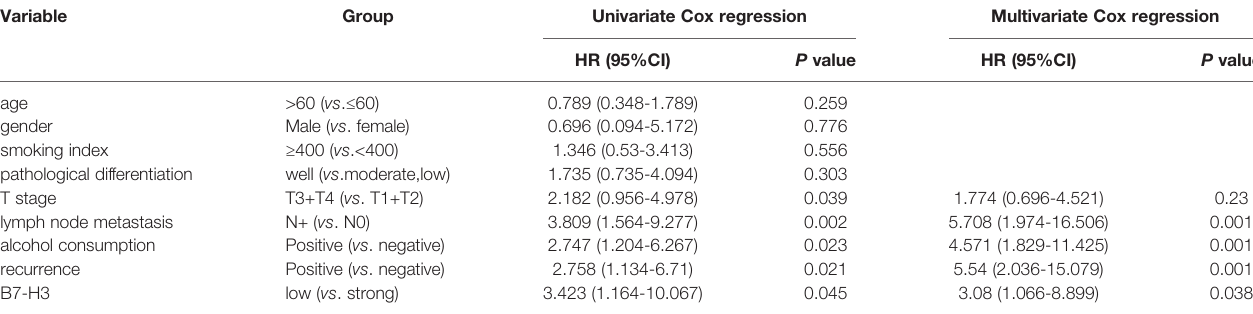
TABLE 2 | Univariate and Multivariate Cox proportional hazards analysis for overall survival in 122 LSCC patients. Variable Group